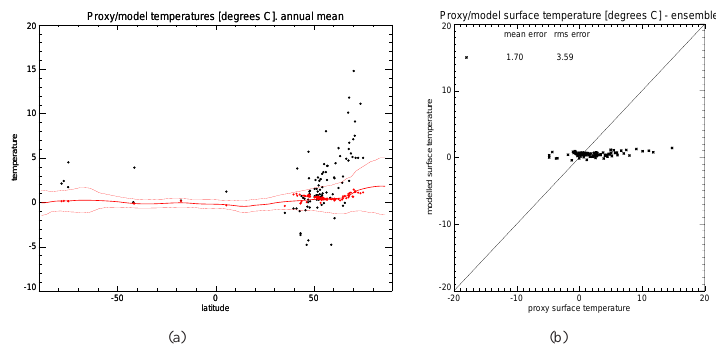
Fig. 7. Comparison of ensemble mean surface air temperature change, LIG minus pre-industrial, with data from Turney and Jones (2010). (a) Latitudinal distribution of proxy data (black dots), compared with the ensemble mean model (red dots, from the same locations as the proxy data), with the zonal model ensemble mean (thick red line), and ± 1 standard deviation of the zonal model ensemble mean (thin red lines). (b) Modelled ensemble mean temperature vs. proxy data temperature for each terrestrial site in the Turney and Jones (2010) dataset. All units are ◦